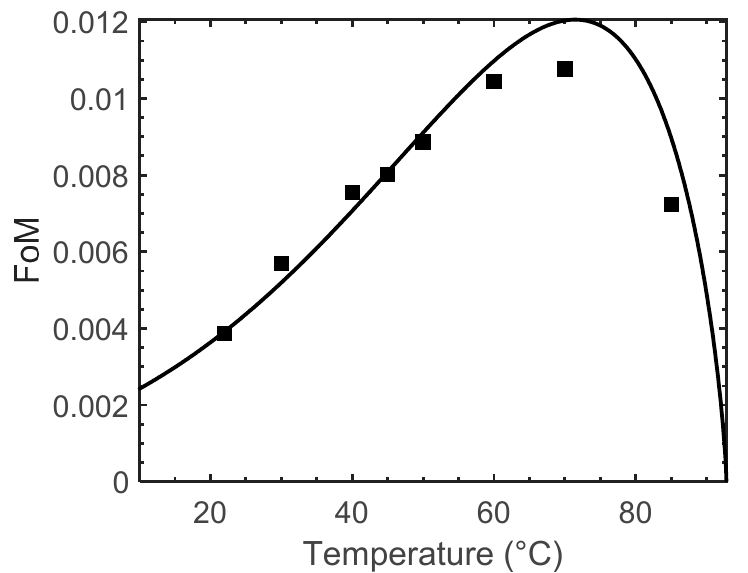
Figure 4. Temperature-dependent FoM of DIC A4907. Squares are measured data and solid line is fitting curve. Table 2. Fitting parameters obtained through Equations (1)–(3).